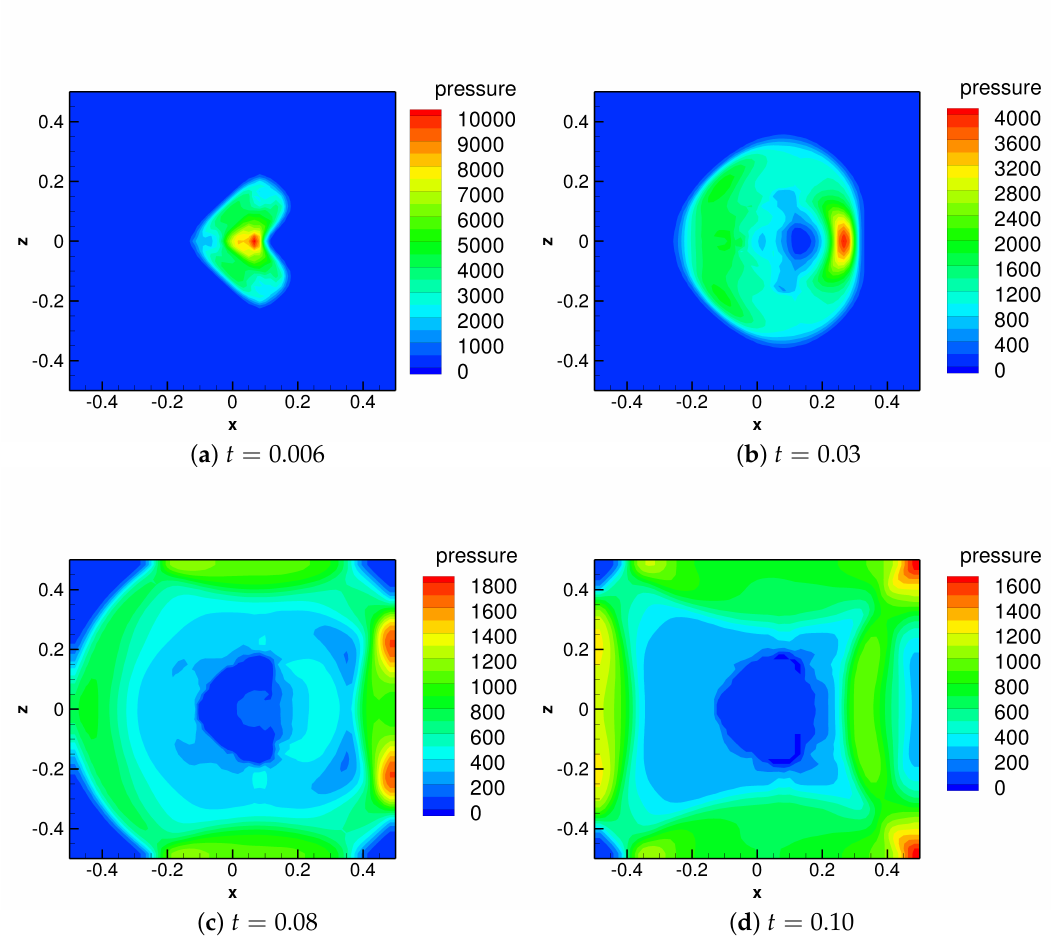
Figure 11. The temporal evolution of the pressure field for an initially bullet-like bubble in slice plots ( y = 0.0). Note that in ( a , b ), the maximum value of the legend is 10,000 and 4000, respectively. The time-dependent pressure curves recorded at Points 1 and 2 are also shown in Figure